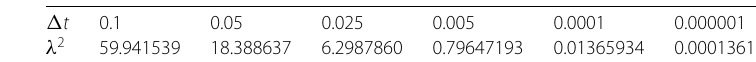
Table 6 β ∼ Beta distribution(1.0,2.0), α = 1 and (cid:4) x = 0.25